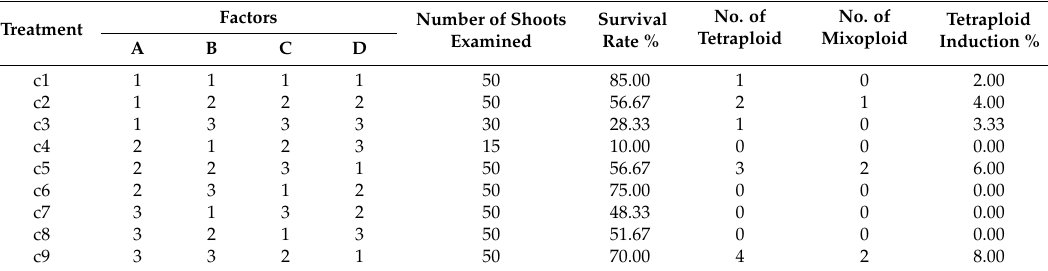
Table 3. Design of orthogonal table L 9 (3) 4 for petioles.